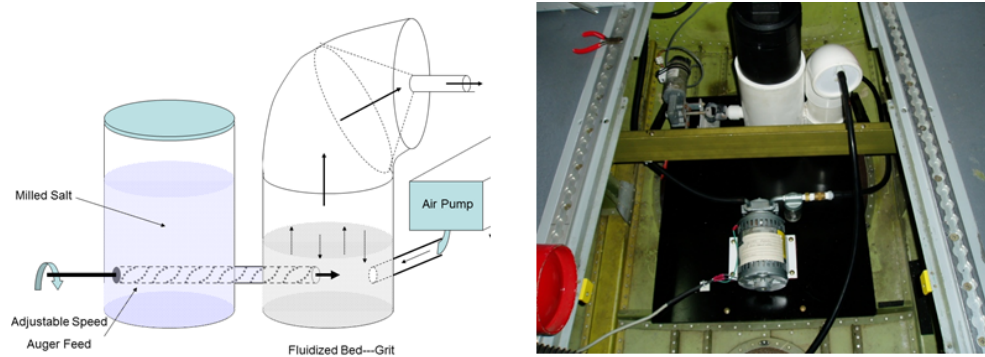
Figure 2. A pictorial schematic and photo of the salt-powder delivery system.